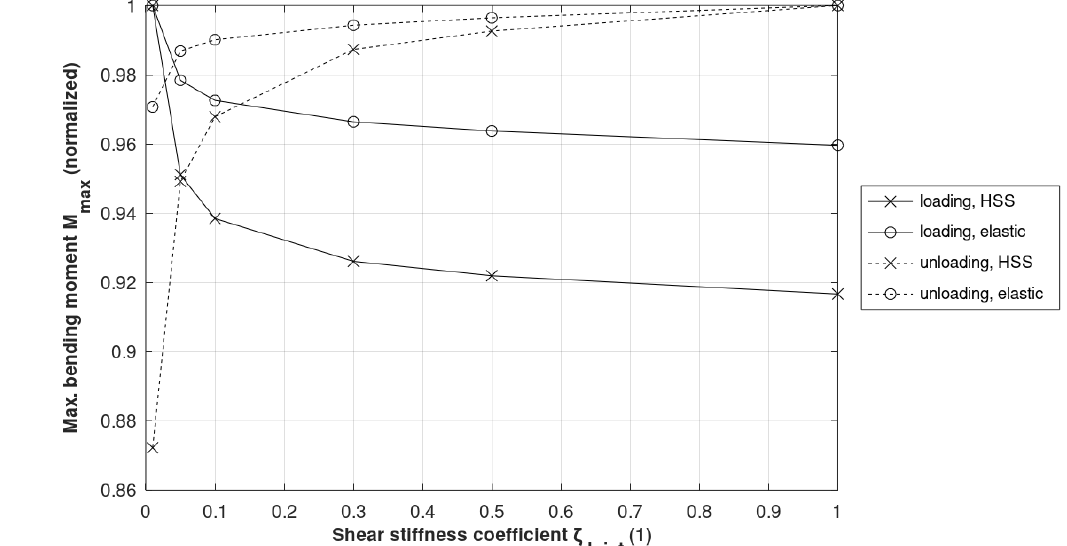
Fig. 14. Relationship between shear stiffness coefficient ζ M (normalized against the extreme value of M max